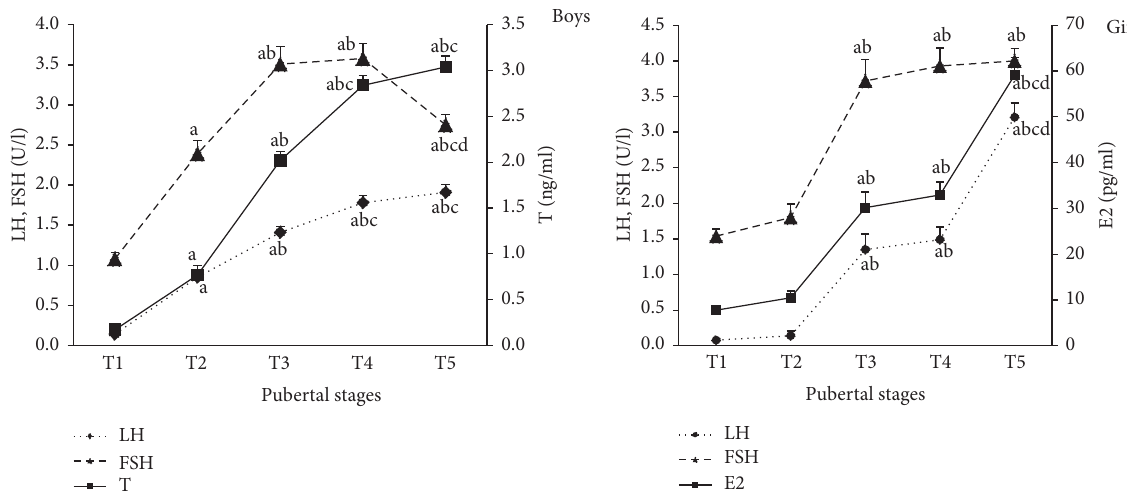
Figure 1: Serum LH, FSH, and T (boys) or E2 (girls) levels in different pubertal stages. (a, b, c, and d compared with T1, T2, T3, and T4, resp., 𝑃 < 0.05 ).